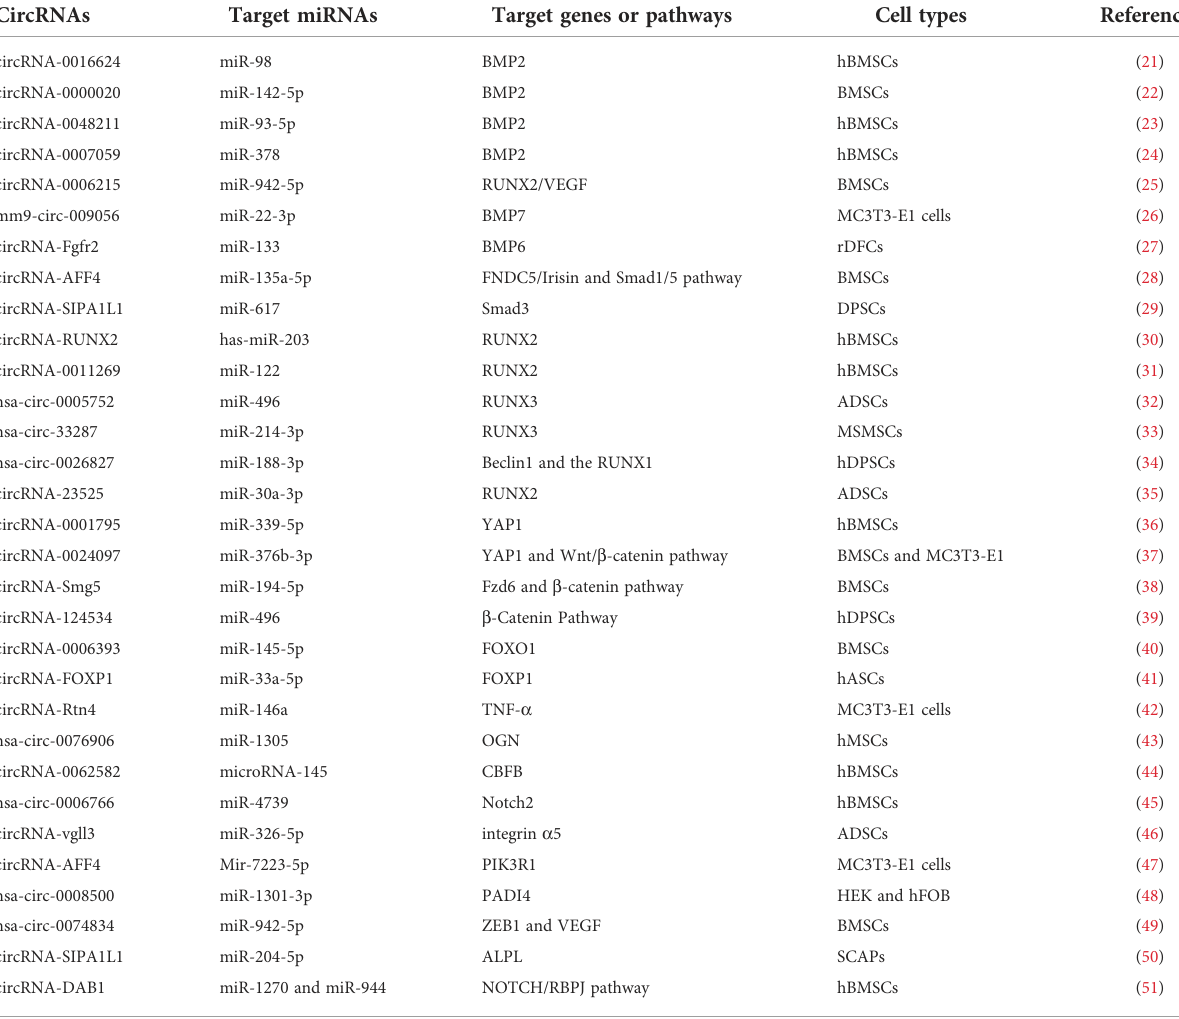
TABLE 1 The auxo-action of the circRNA – miRNA – mRNA axis during bone